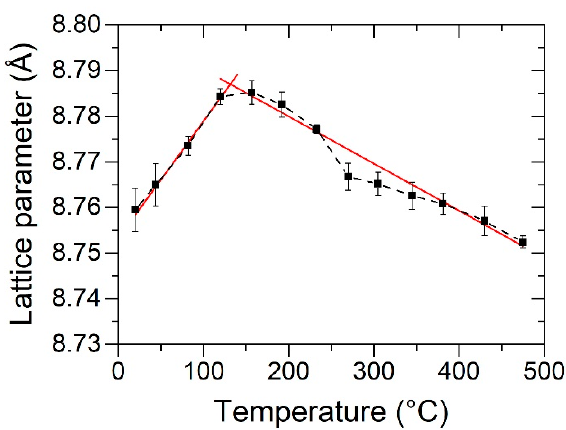
Figure 7 . Lattice parameter of synthesized cubic HfV 2 O 7 as a function of annealing temperature obtained by X-ray diffraction. A linear fit within the positive and negative thermal expansion range, respectively, was added (red).